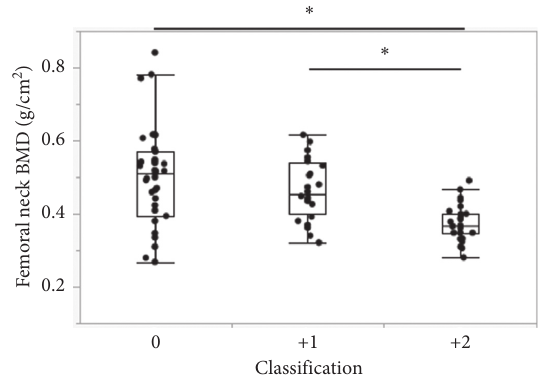
Figure 3: Comparison of BMD according to the Aortic Arch Tail Sign Classification. BMD in the +2-line group was significantly lower than that in the 0- and +1-line groups ( ∗ p < 0 . 01).